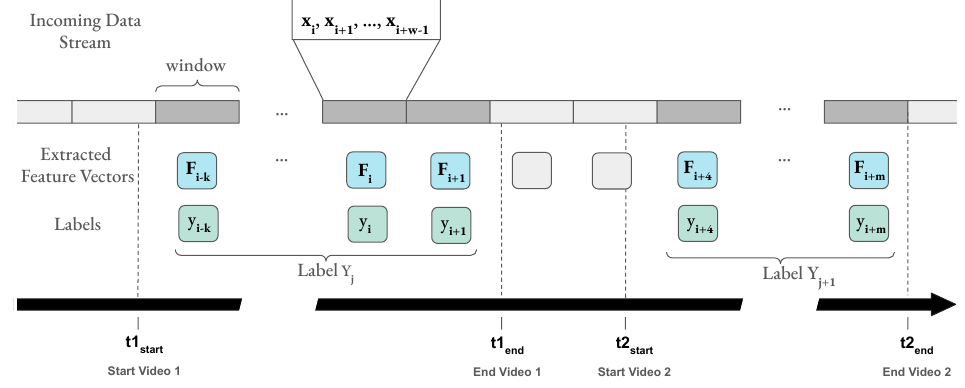
Figure 7. The incoming data stream is processed in tumbling windows (gray rectangles). One window includes all samples x i , x i + 1 , . . . arriving during a specified time period, e.g., 1 s. The pipeline extracts one feature vector, F i , per window. Windows during a stimulus (video) are marked in dark gray. Participants rated each video with one label per affect dimension, Y j . All feature vectors extracted from windows that fall into the time frame of a video (between t start and t end of that video) receive a label y i corresponding to the reported label, Y j , of that video. If possible, the windows are aligned with the end of the stimulus; otherwise, all windows that lie completely inside a video’s time range are